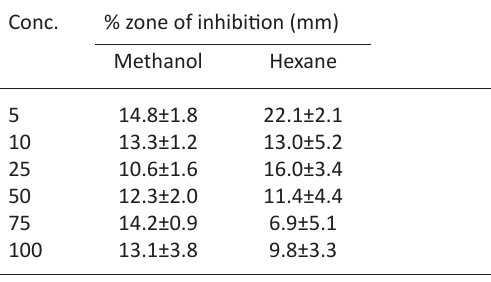
Table 2. Mean and Standard deviation for methanol and hexane extracts for C. cinereum at 100%, 75%, 50%, 25%, 10% and 5% concentration against S. aureus